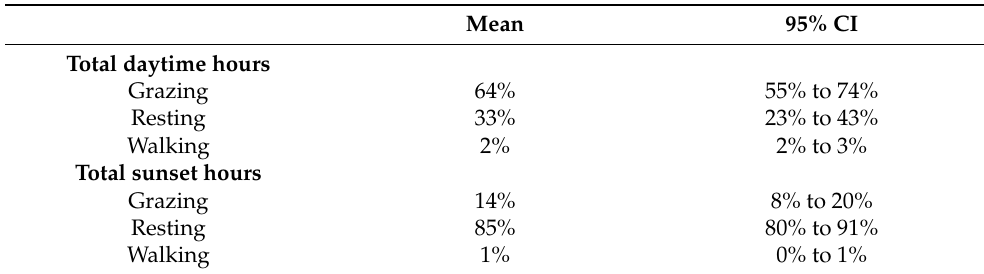
Table 8. Activity time budgets of grazing sheep during 11 h of daytime and 13 h of sunset hours derived from neck collar mounted accelerometers on 10 ewe lambs over three monitoring days.